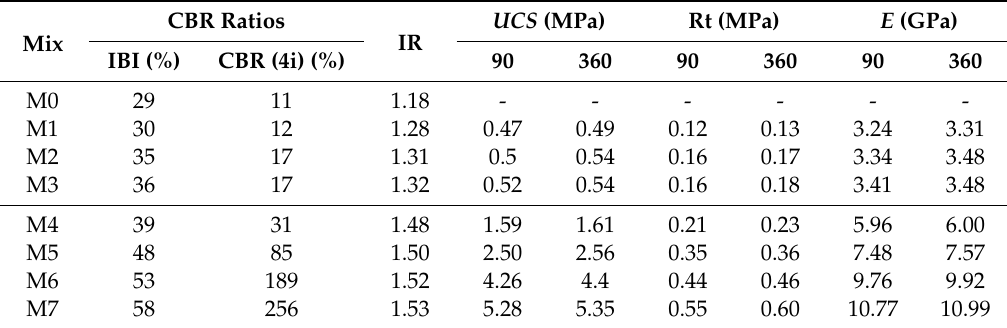
Table 7. Results of mechanical properties of designed